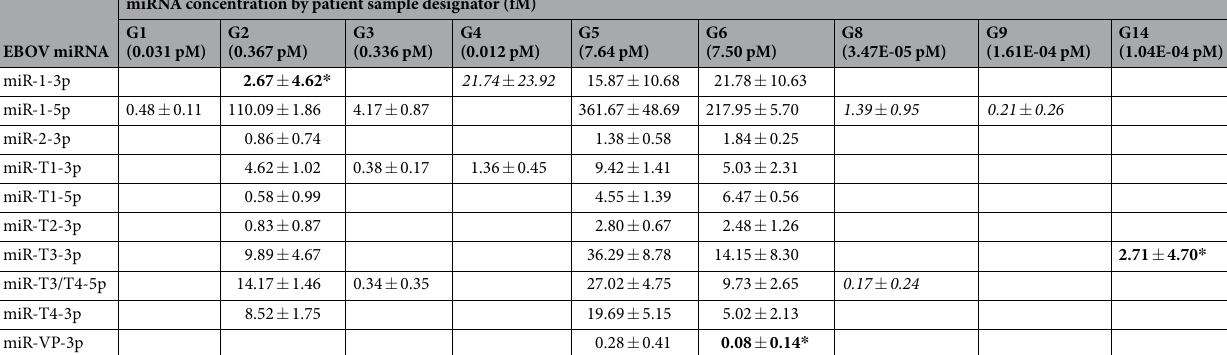
Table 4. EBOV miRNAs were present in human samples during infection with EBOV/Makona. Note: Data are presented as the mean ± SD of three technical replicates. Values in bold font indicate amplification in only one of three replicates. Blank cells indicate that the corresponding miRNA was not detected. The corresponding EBOV load for each individual is given in parentheses below the patient designator. Values in italicized font denote miRNA concentration higher than viral